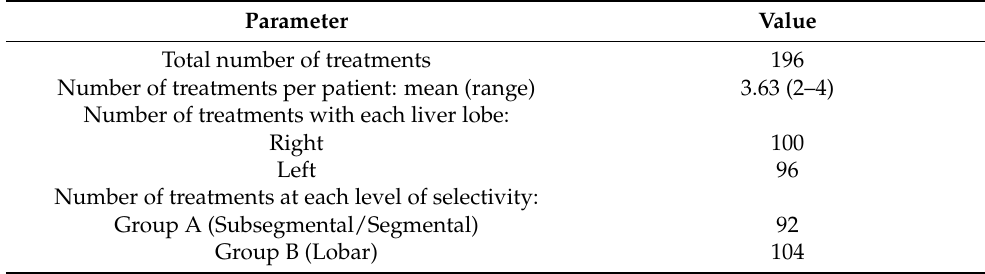
Table 1. Technical details of therapy with drug-eluting microspheres (100 µ m) loaded with irinotecan.